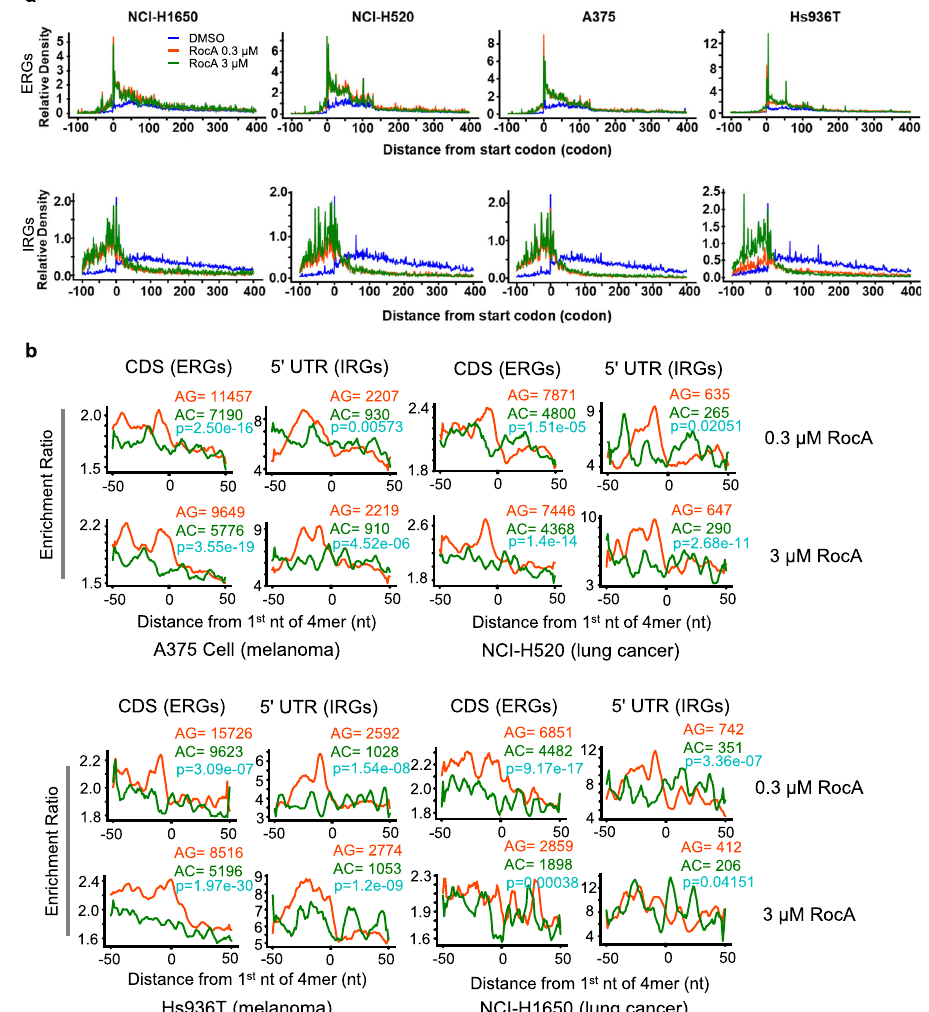
Fig. 6 | Perturbationof translation elongation inducedby RocA in lung cancer and melanoma cells. a Metagene plots of ERGs and IRGs with ribosome pro fi ling data from different cancer cell lines. Melanoma: A375 cells and Hs936 cells; lung cancer:NCI-H1650cellsandNCI-H520cells. b Enrichmentratioofribosomedensity